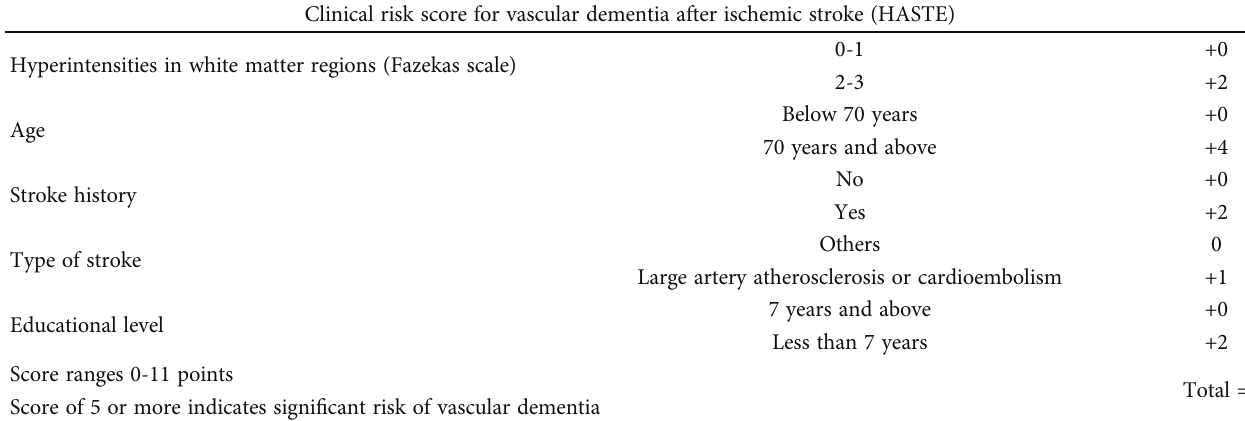
Table 3: Clinical risk score for vascular dementia after ischemic stroke (HASTE).